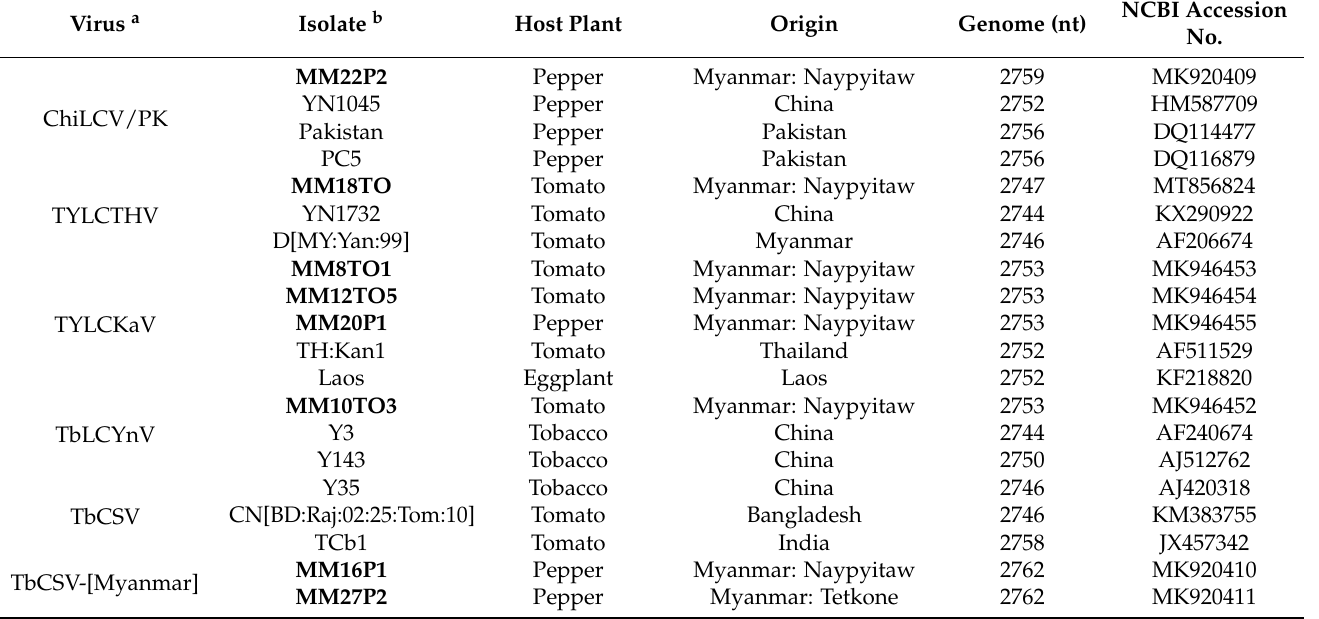
Table 2. Database of the complete nucleotide sequences of monopartite or DNA-A of begomoviruses isolated from Myanmar and reference sequences.